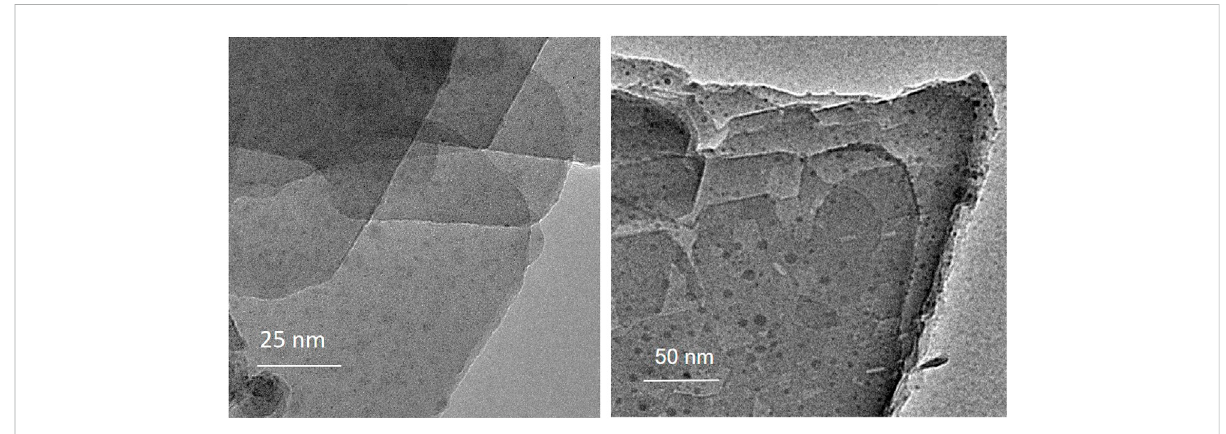
FIGURE 4 TEM images of calc-CuFeMn – NaZ-50 (left) and postcalc-CuFeMn – NaZ-50